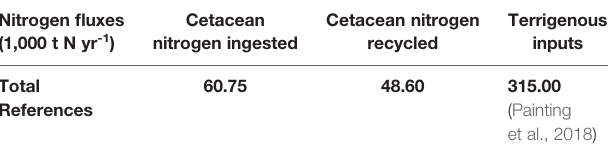
TABLE 9 | Summary of survey area nitrogen fl uxes.